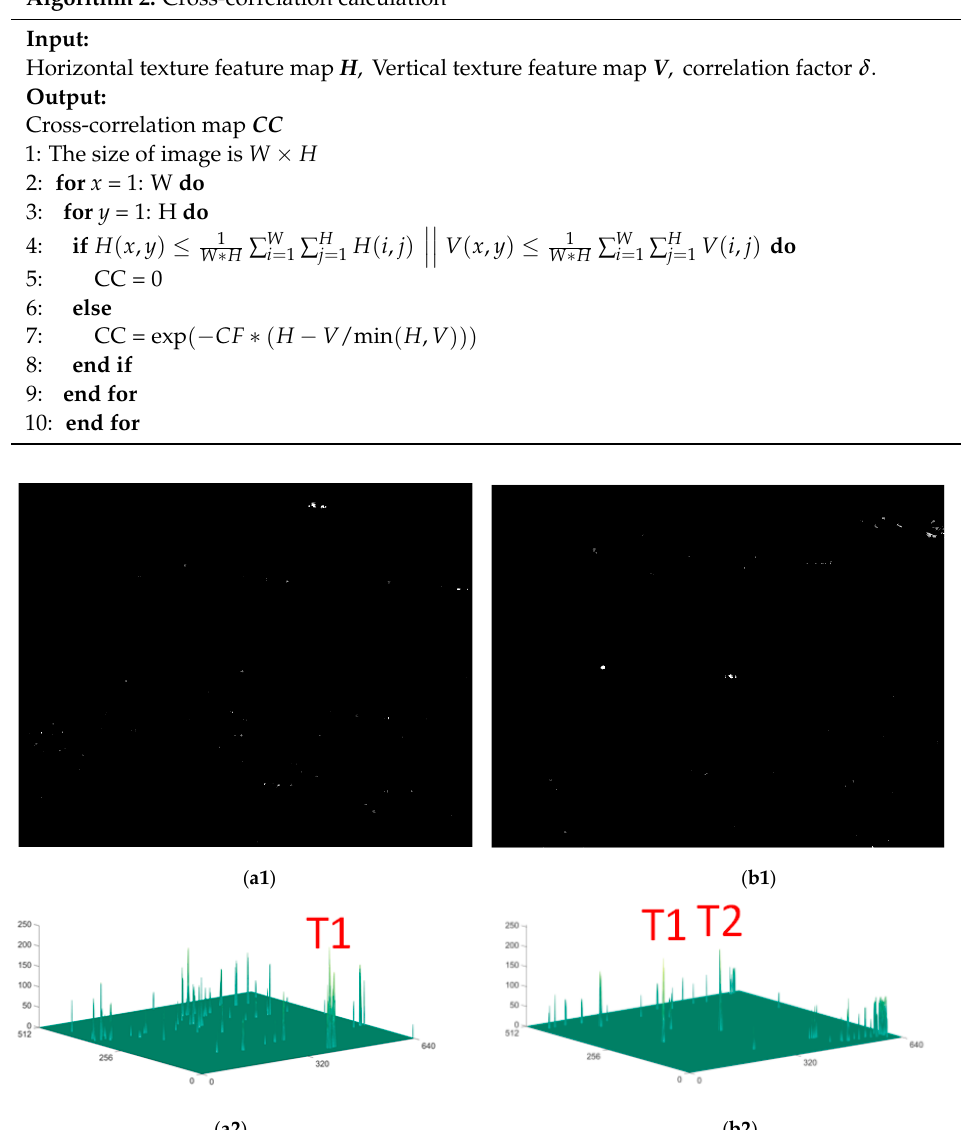
Algorithm 2: Cross-correlation calculation